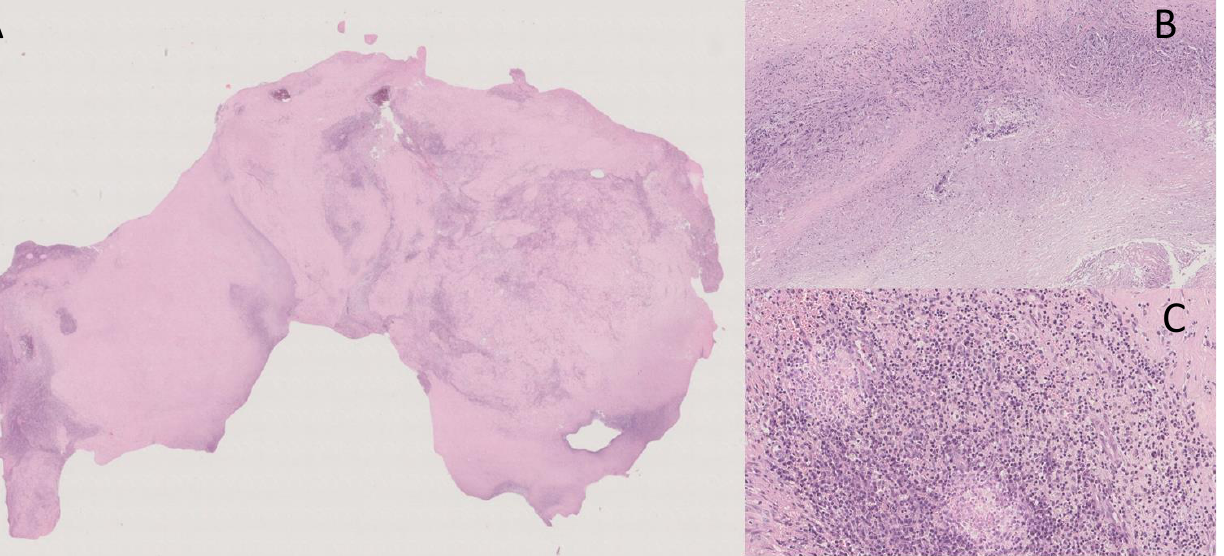
Figure 3. ( A ): Extensive fibrosis and dystrophic calcification (Hematoxylin and Eosin, 0.5×); ( B ): Figure 3. ( A ) Extensive fibrosis and dystrophic calcification (Hematoxylin and Eosin, 0.5 × ); ( B ) Sup- Suppurative necrosis (Hematoxylin and Eosin, 5×); ( C ): Lymphomonocytic, plasma cell and purative necrosis (Hematoxylin and Eosin, 5 × ); ( C ) Lymphomonocytic, plasma cell and granulocytic granulocytic infiltrate (Hematoxylin and Eosin, 20×). infiltrate (Hematoxylin and Eosin, 20 ×